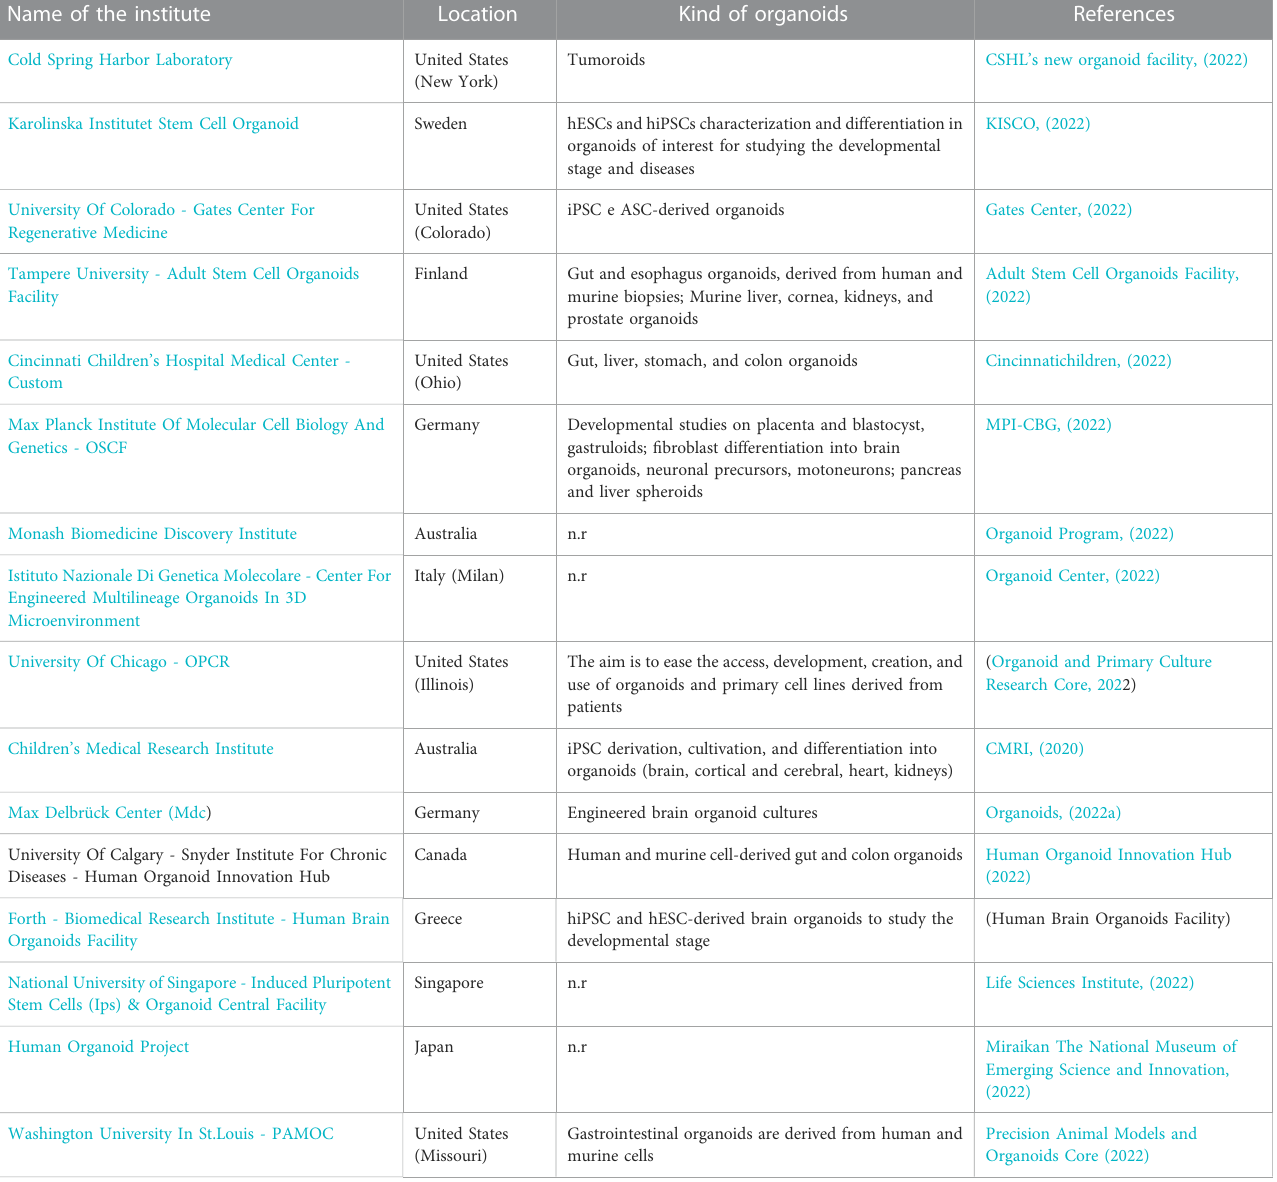
TABLE 3 Research institutes around the world that have a Research and Development (R&D) laboratory dedicated to organoid